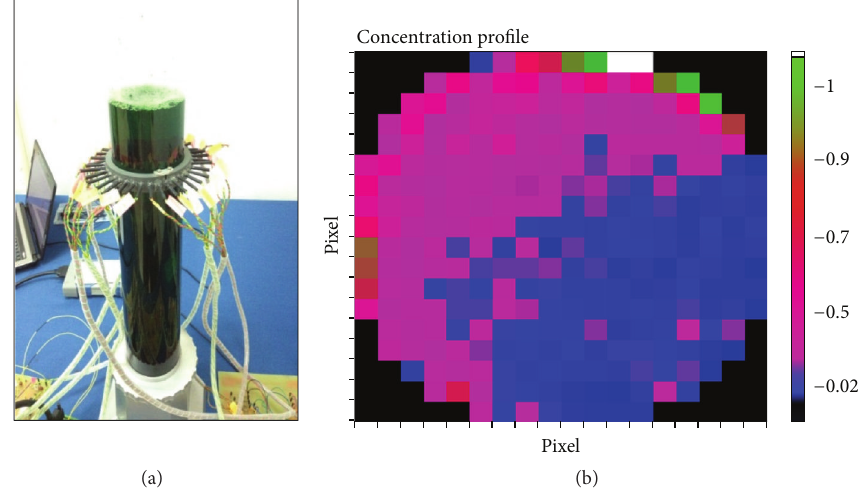
Figure 12: (a) The condition of 50% of air opening. (b) The concentration profile for 50% of air opening.